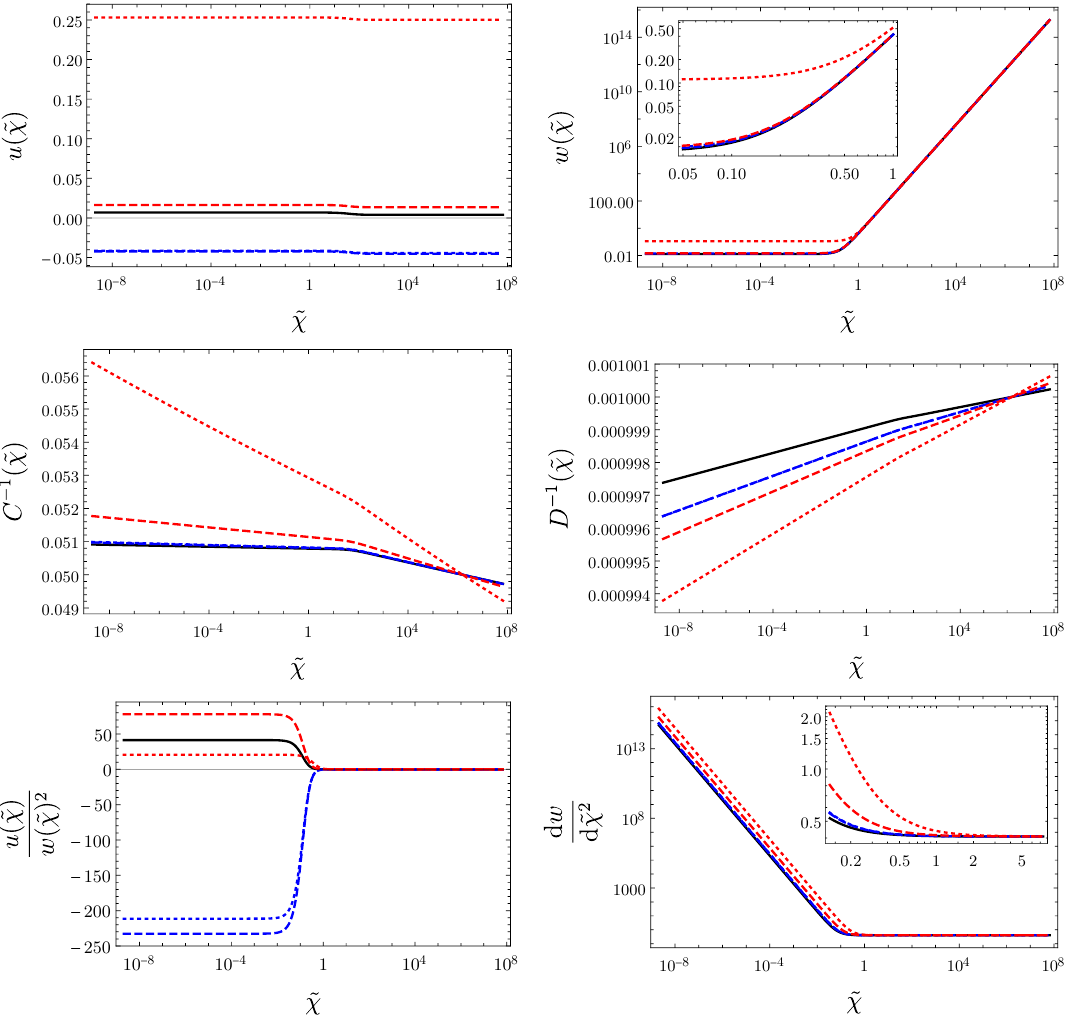
Figure 8 . Critical trajectories of u (top-left), w (top-right), C − 1 (middle-left), D − 1 (middle-right) u/w 2 (bottom-left) and d w/ d ˜ χ 2 (bottom-right) as functions of ˜ χ in various models. The solid black line shows the pure gravity case, the blue dashed and dotted lines are the cases of the SM and the SM including a singlet scalar, respectively, and the red dashed and dotted lines are GUTs (SU(5) and SO(10)),